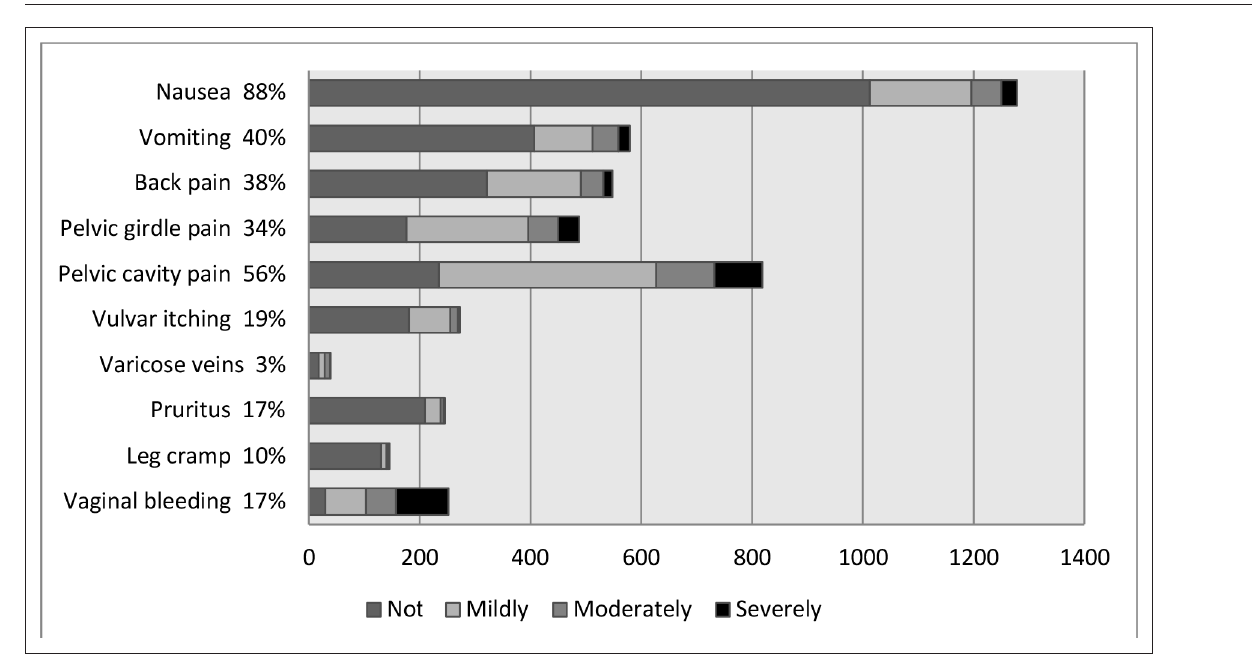
Figure 1 Prevalence and degree of worry for each pregnancy- related physical symptom. Each row illustrates the prevalence of a symptom (any degree). The number of women worried by each symptom is illustrated by the different shading (not, mildly, moderately, and